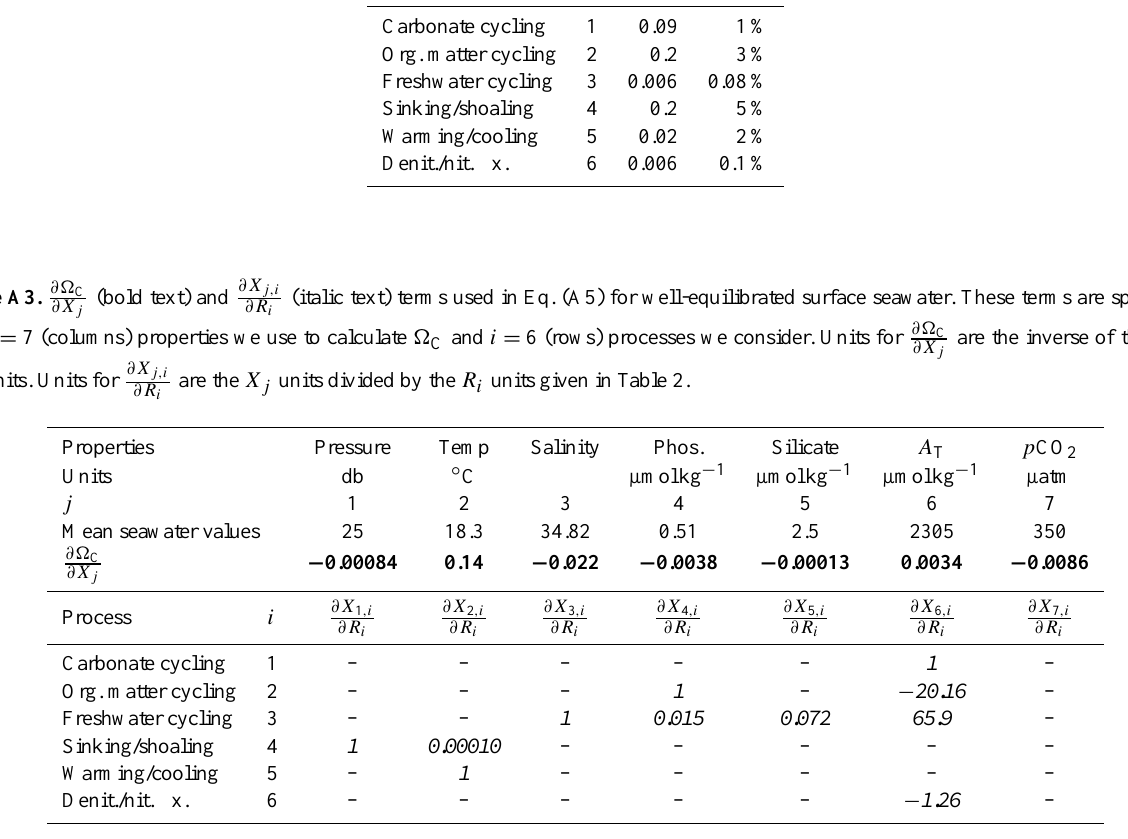
Table A2. Monte Carlo-derived estimates for M i variability ( σ M all ocean depths.